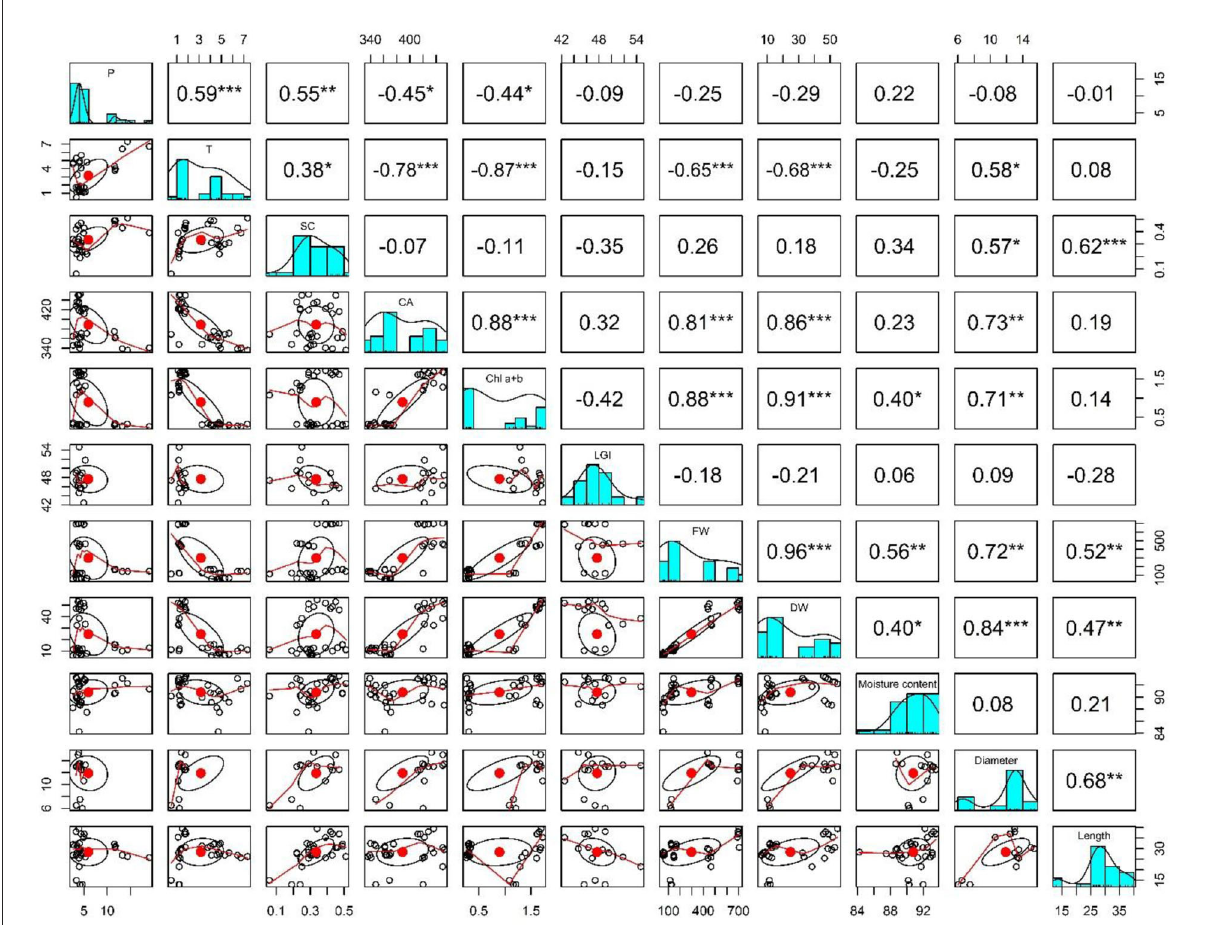
FIGURE7 Pearson correlation indicating the relation between assessment parameters: P is Photosynthetic rate, T is Transpiration rate, SC is Stomatal conductance, CA Internal CO 2 concentration, Chl a + b is Photosynthetic pigments, LGI is Leaf greenness indexes, FW is Plant fresh weight, DW is Plant dry weight, Moisture content is Moisture content, Diameter is Root diameter, and Length is Root length. The * indicates week relationship, ** shows strong, and *** shows very strong